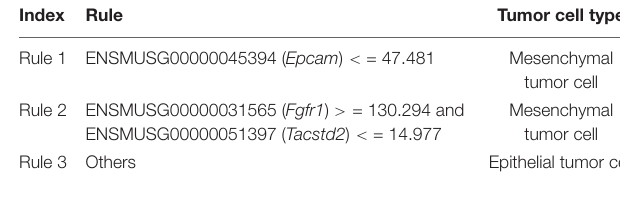
TABLE 2 | Three classification rules learned by repeated incremental pruning to produce error reduction (RIPPER).